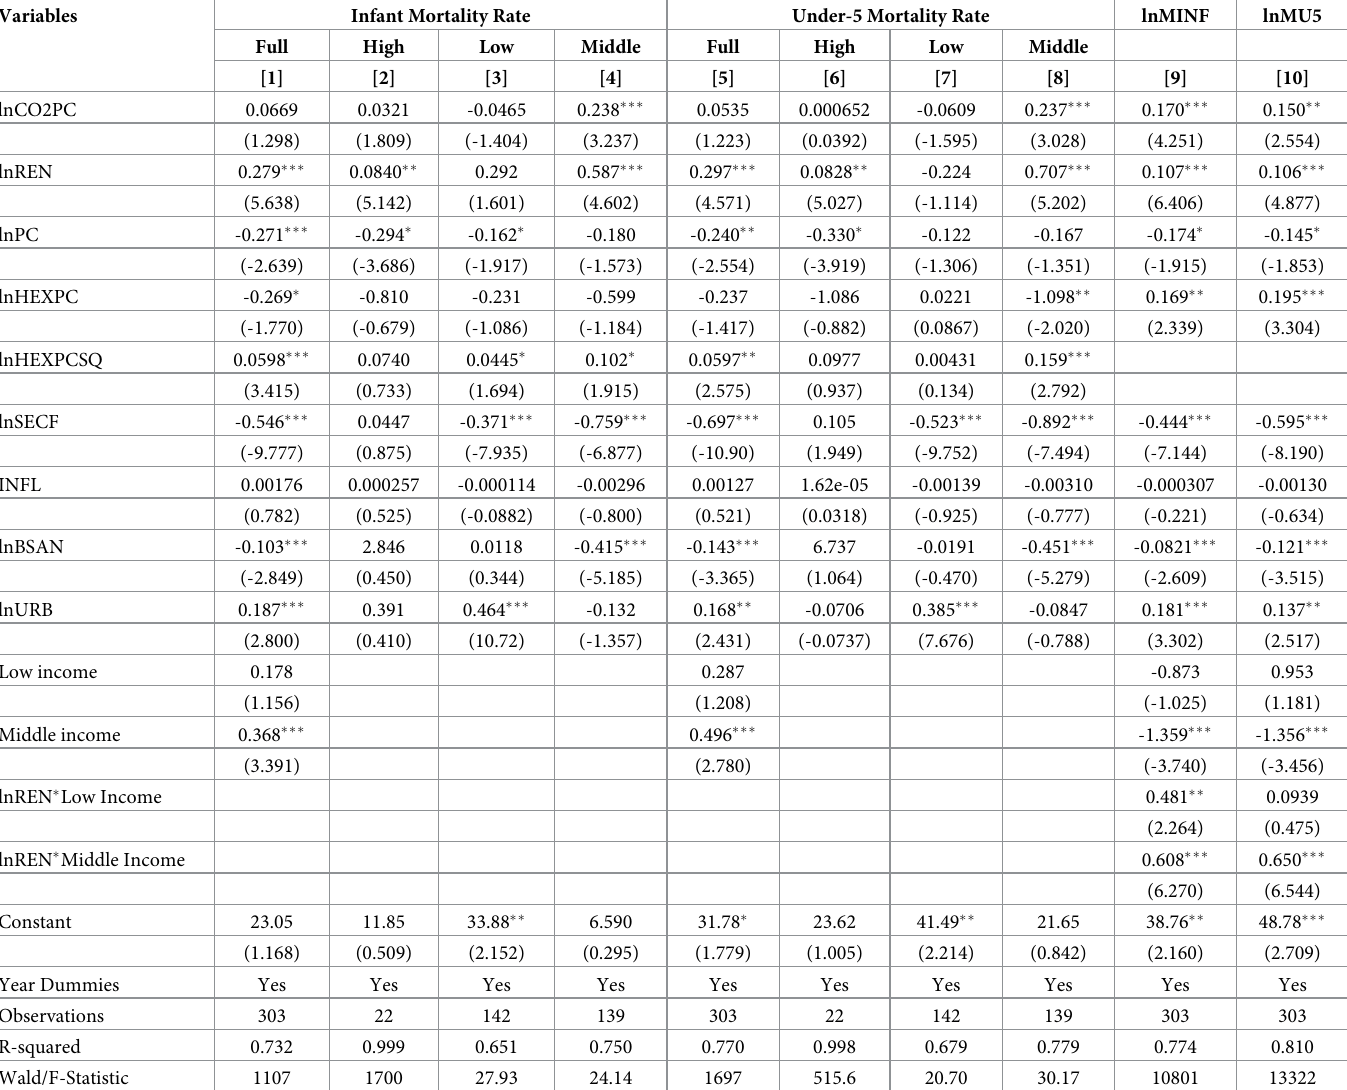
Table 7. Robustness checks on lnHEXPC and lnREN (full and income